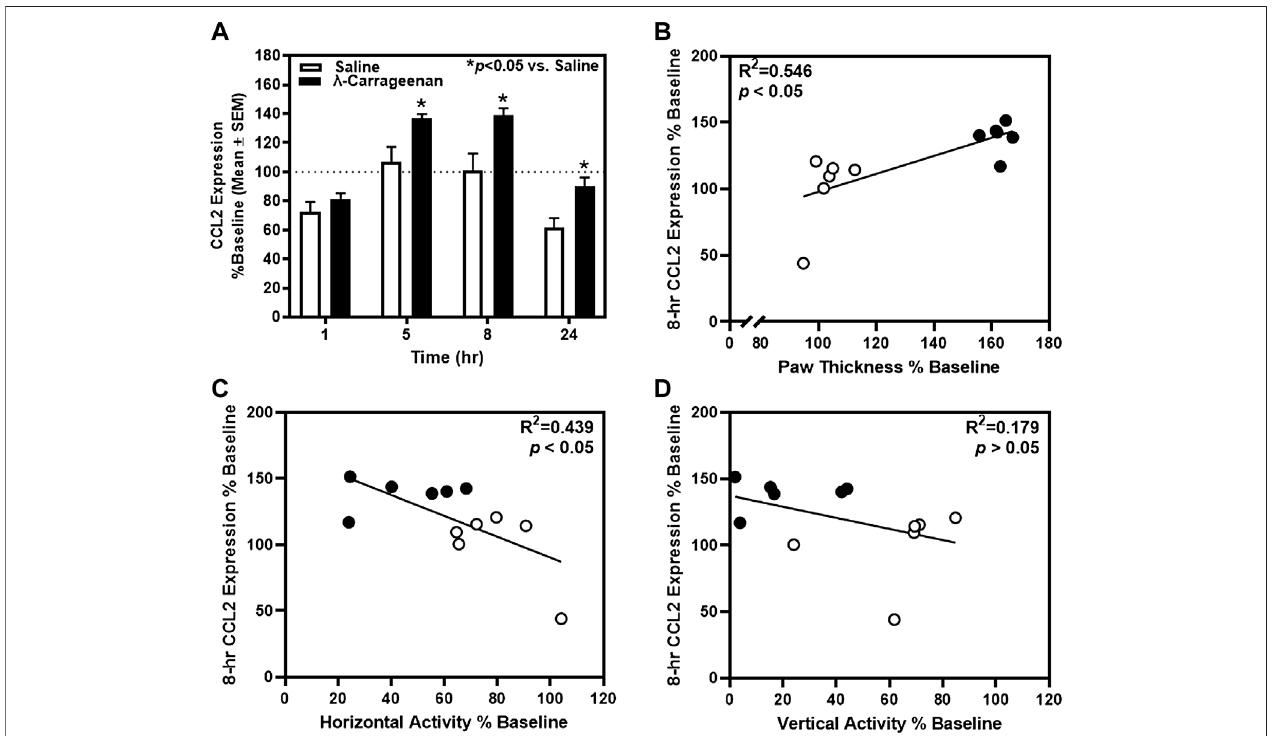
FIGURE 5 | The impact of λ -carrageenan on the timecourse of CCL2 expression is presented with correlational analyses. (A) The percent baseline CCL2 expression wascalculated asthemeanvalue at each time pointfollowingtreatmentwithsaline (white bars)or λ -carrageenan(black bars), normalizedtobaseline values. λ -Carrageenan signi fi cantly increased CCL2 expression relative to saline at the 8 and 24 h timepoints (* p < 0.05 vs. Saline). CCL2 expression (B) positively correlated with paw thickness and (C) negatively correlated with horizontal activity at the 8 h timepoint. (D) No signi fi cant correlation between CCL2 expression and vertical activity was